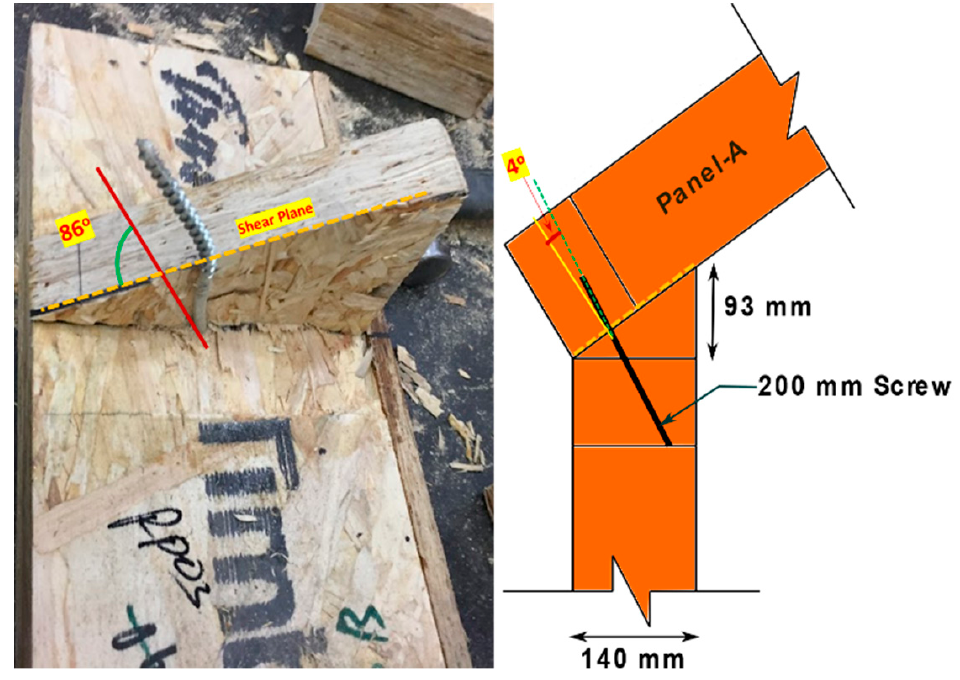
Figure 29. Connection -A shear plane. Table 4. Theoretical load-bearing capacity